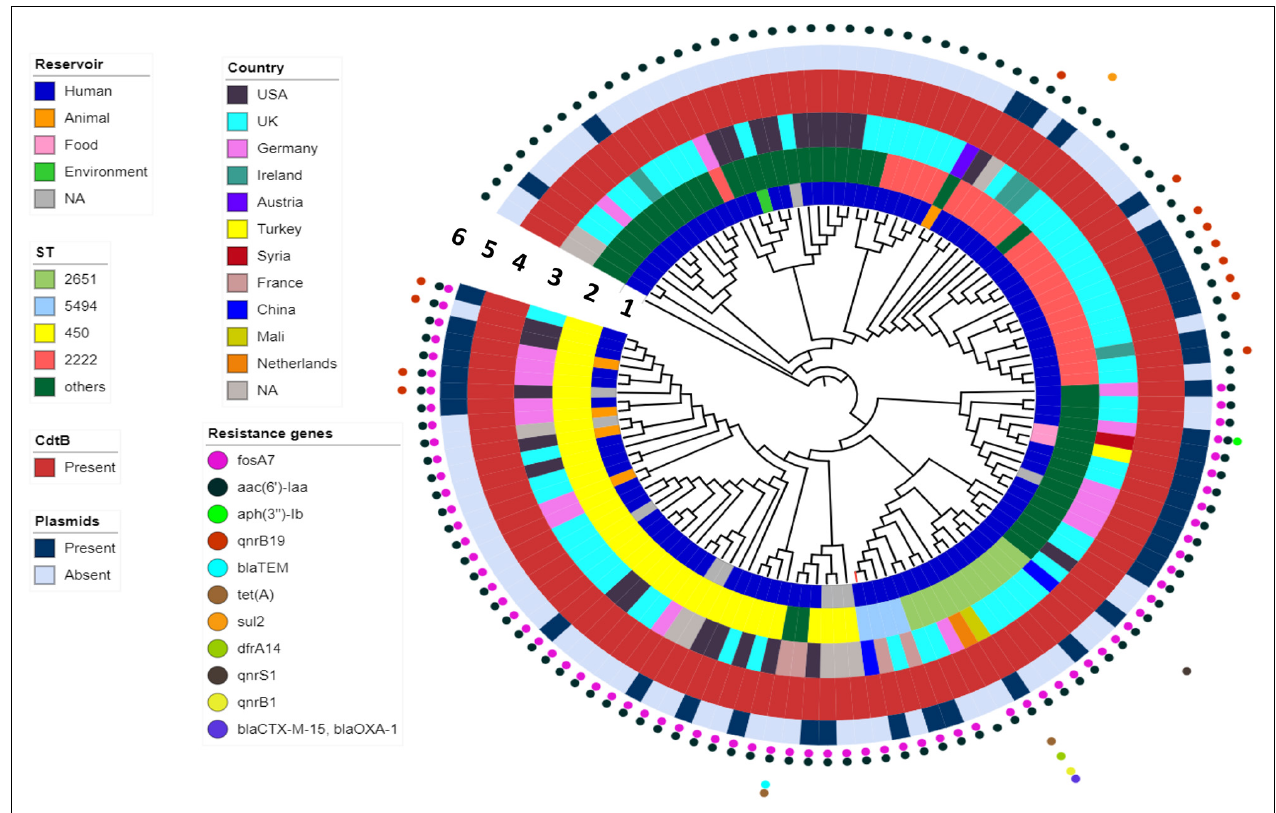
FIGURE 3 | The phylogenomic relationship among 121 Salmonella Telelkebir strains. The tree has been rooted using the serovar Poona ATCC R (cid:13) BAA-1673 as the outgroup. The numbers 1–6 represents the inner to outer rings corresponding to reservoir, ST, country, cdtB , plasmids, and resistance genes, respectively. The strain FJ001 containing leaf node is represented in red. The following plasmids were present in the Telelkebir strains: IncI1 α , IncFII, Col440I, IncHI2, IncN, and IncI2 (Delta).